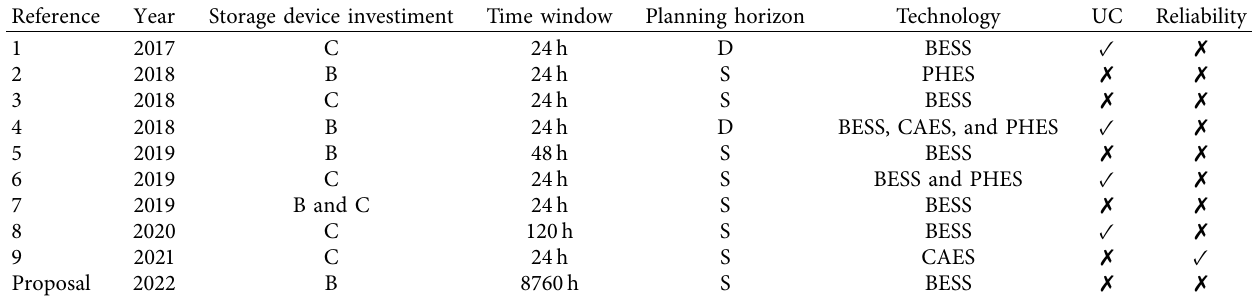
Table 1: Taxonomy of recent publications that propose methodologies for solving co-planning of transmission and storage devices.